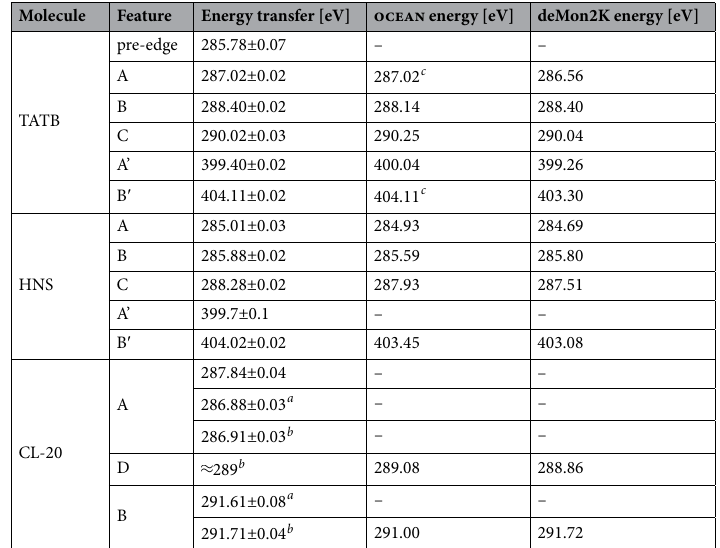
Table 1. Transition energies of noticeable spectral features. Listed energy values correspond to peak maximum with the exception of TATB pre-edge where the onset value is given instead 12 . Note, only relative energies are calculated with ocean (see text), and peak A (B ′ ) of TATB was used to align the carbon (nitrogen)